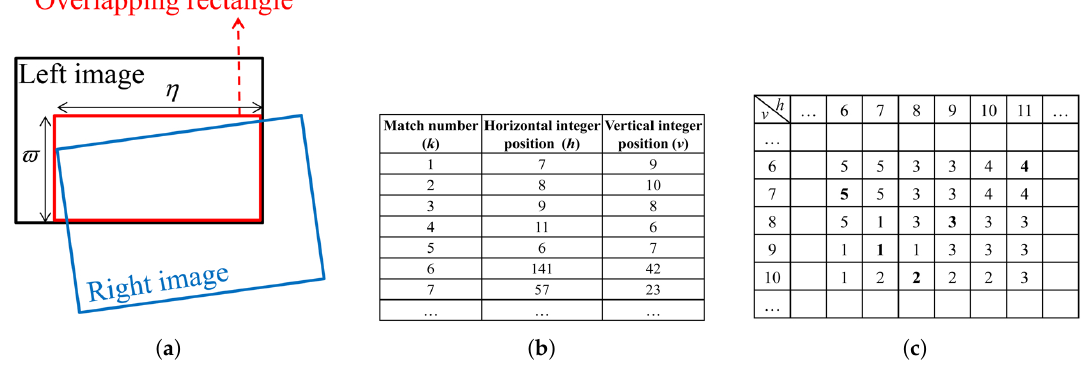
Figure 2. Encoding scheme: ( a ) the overlapping rectangle, ( b ) an example list of some putative correspondences, which are identified by their indices, and their positions relative to the overlapping rectangle and ( c ) a part of the 2D lookup table constructed using Equation (6); the bold numbers show the indices of the original matches, and the regular numbers show the indices assigned to the other